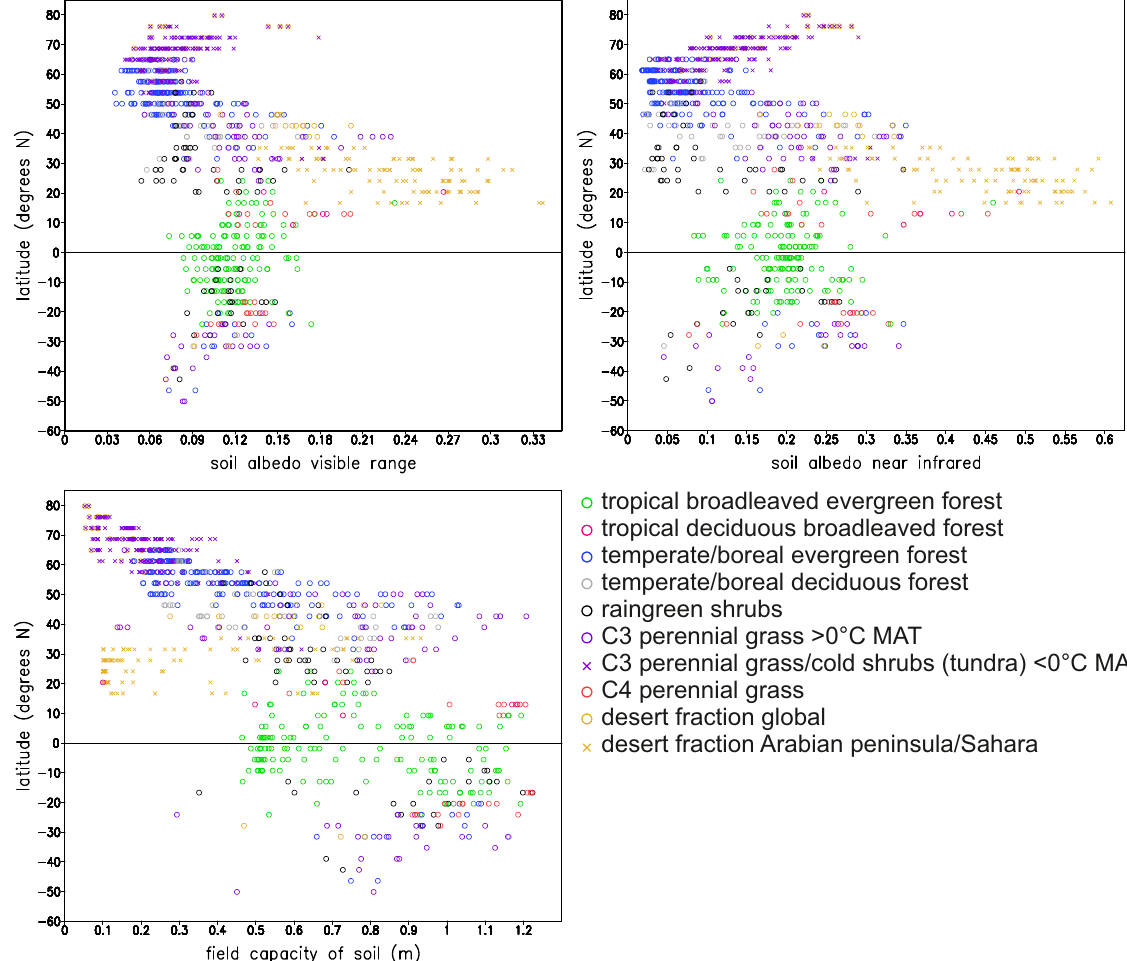
Figure 2. Physical soil properties (abscissa) used in the dynamical vegetation module JSBACH associated with plant functional types along latitudes. Albedo values are derived from modified satellite measurements of the Moderate Resolution Imaging Spectroradiometer (MODIS; Rechid et al., 2009), and total water-holding field capacity of soils are taken from Hagemann et al.